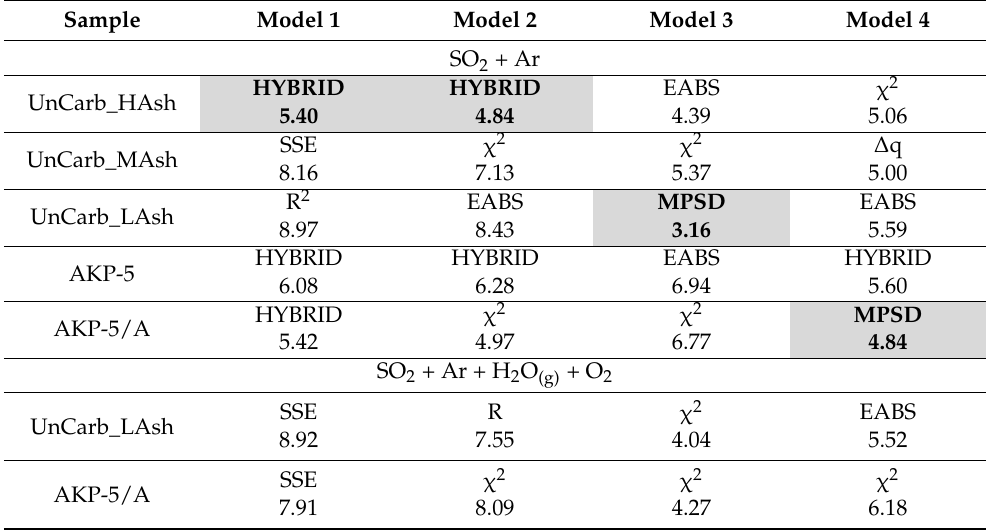
Table 4. SNE error analysis for kinetic models solved by non-linear regression method—the most appropriate